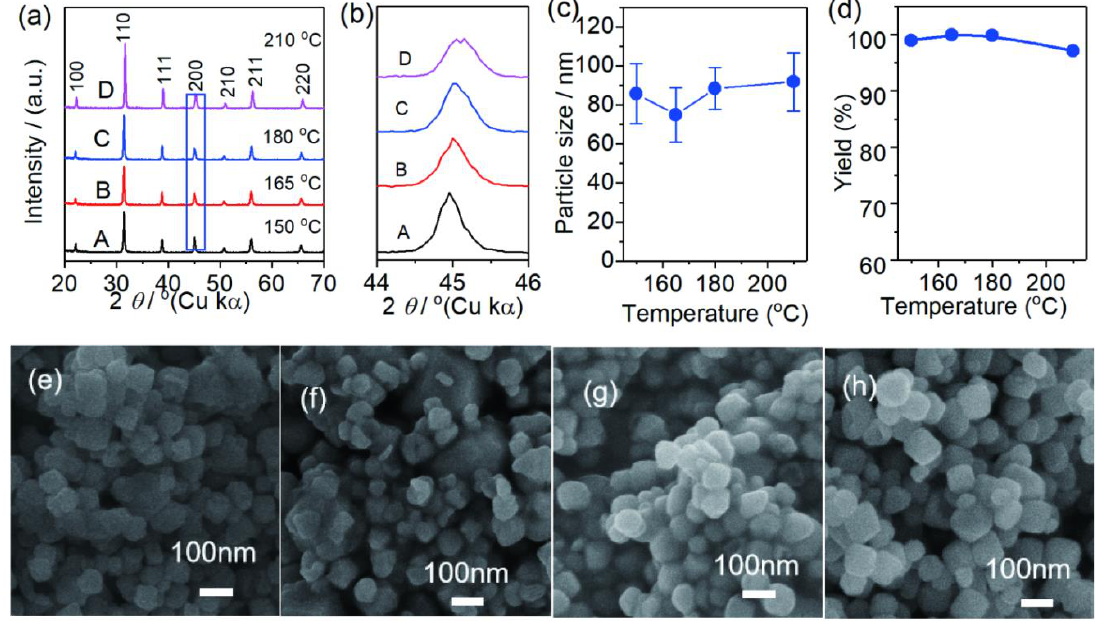
Figure 4. XRD patterns ( a , b ), particle sizes and yields ( c , d ), and SEM images ( e – h ) of the BaTiO 3 nanocrystals obtained with R Ba/Ti = 2.0 under hydrothermal conditions at 150–210 °C for 8 h ([NaOH] = 2.0 mol L −1 , pH ≈ 13.6).